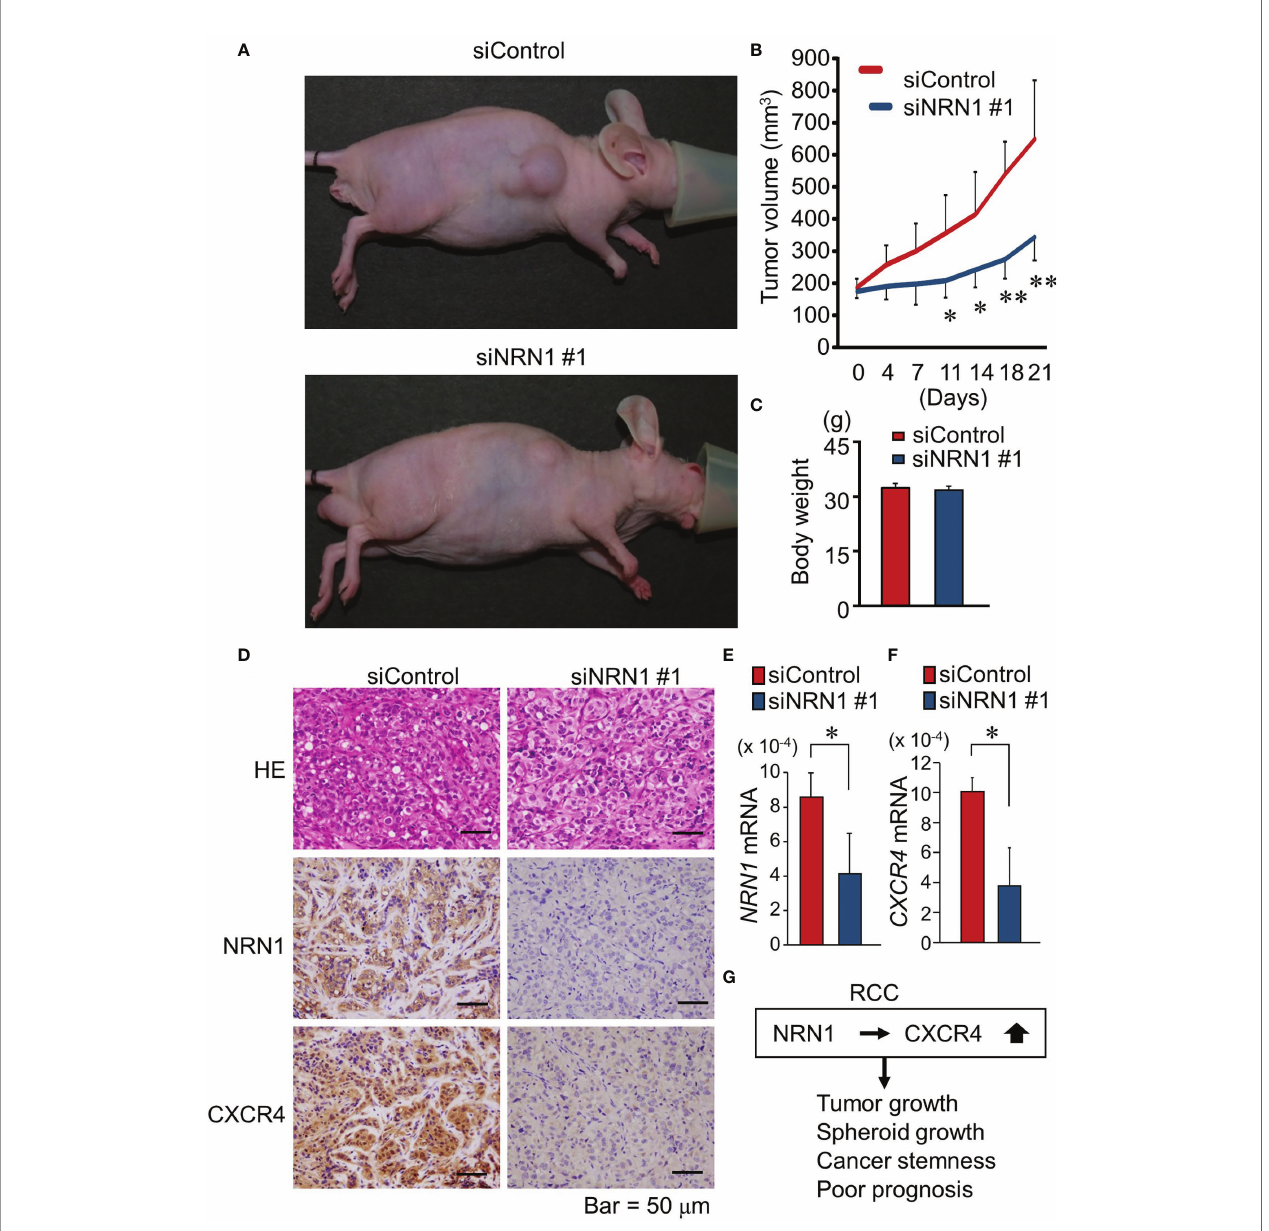
FIGURE 4 | NRN1 silencing suppresses in vivo growth of RCC-PDC-derived xenograft tumors. (A) Representative images of xenograft tumor-bearing nude mice at time of sacri fi ce. (B) Volume of xenograft tumors derived from RCC-PDC1 cells treated with siControl ( n = 5, red) or siNRN1 #1 ( n = 5, blue). (C) Body weights of mice at time of sacri fi ce. (D) Representative images of hematoxylin and eosin (HE) staining and NRN1 and CXCR4 IHC staining in dissected xenograft tumors treated with siControl or siNRN1 #1. Scale bars, 50 m m. (E, F) NRN1 (E) and CXCR4 (F) levels in xenograft tumors analyzed by qRT-PCR. Data are shown as mean ± SD, n = 5; * P < 0.05, ** P < 0.01 by two-sided Student ’ s t -test. (G) Schematic representation of oncogenic function of NRN1 and CXCR4 in RCC